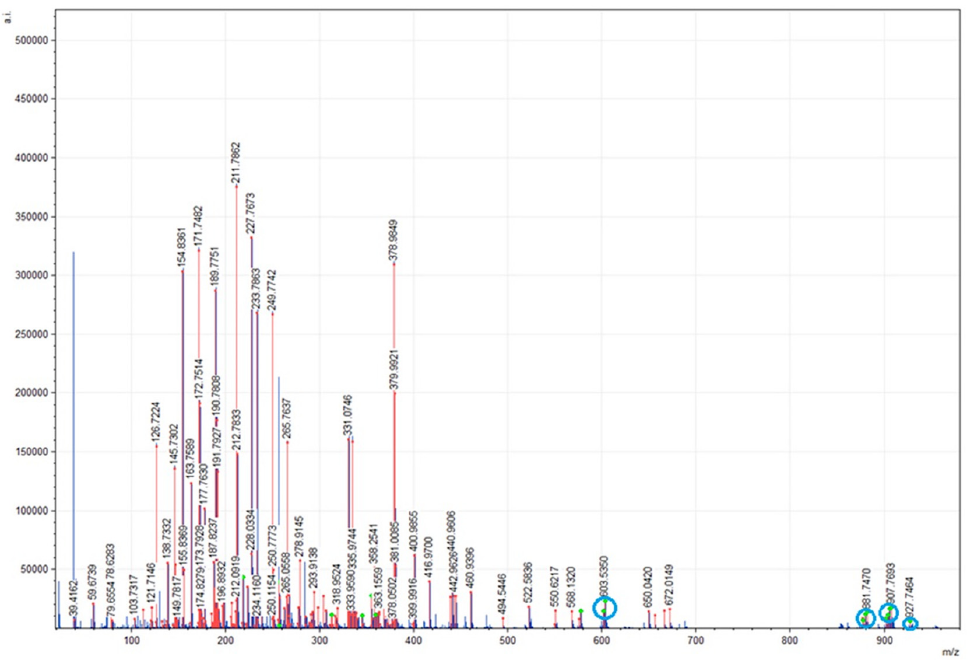
Figure 4. MALDI-TOF mMass report spectrum of glycerolipids profile obtained from CRSO, obtained between 100 and 900 m / z ratio values. The m / z ratio signals corresponding to MG, DG, and TG presenting EPA at the sn -2 position are marked in blue. Database: LIPID MAPS for glycerolipids.